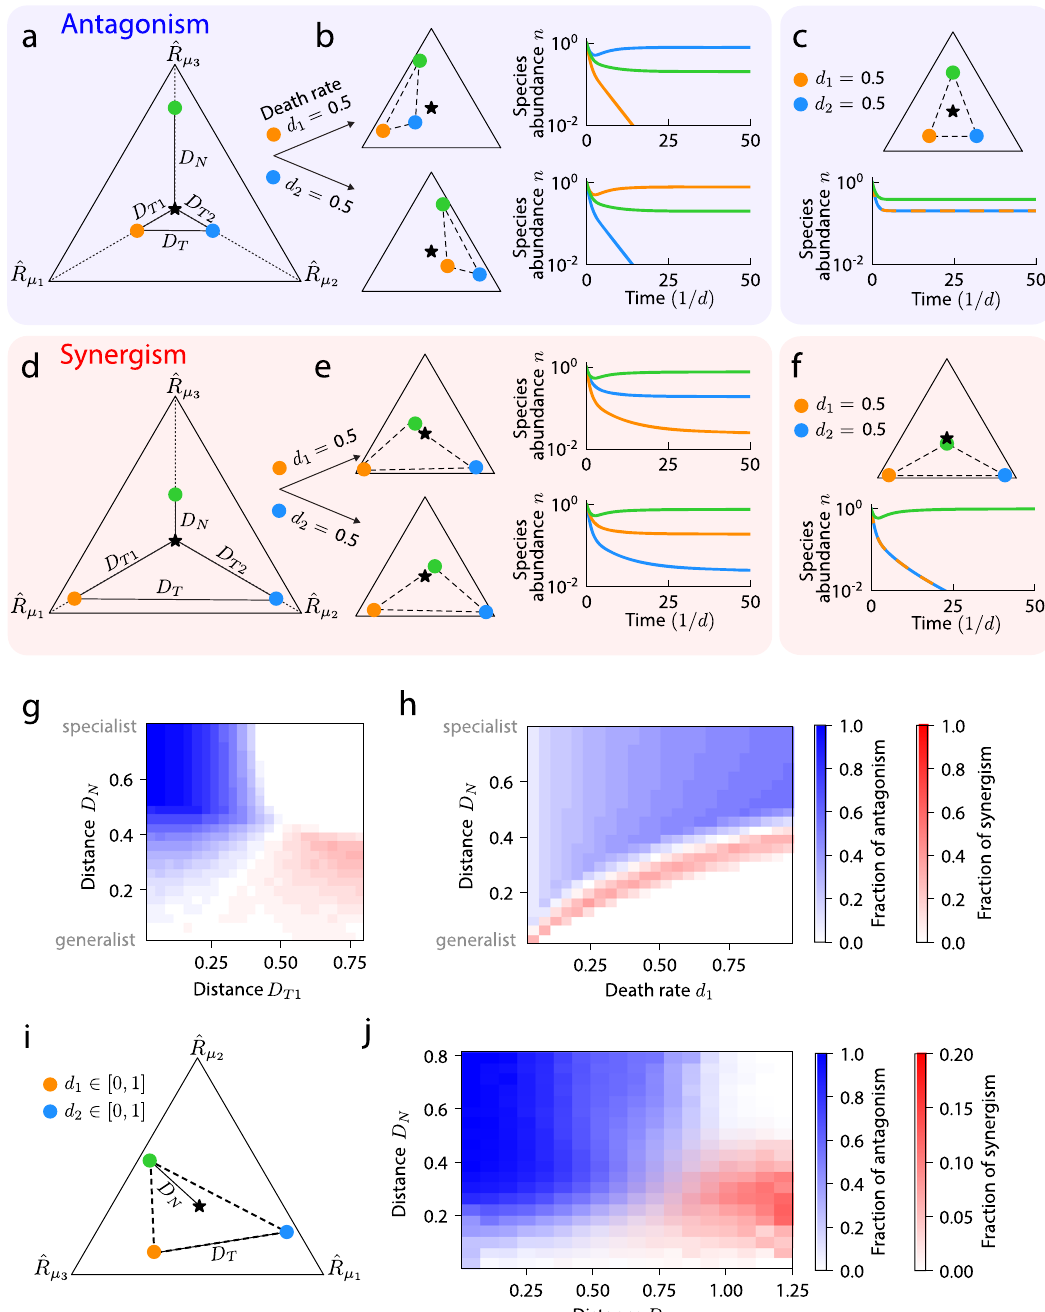
Fig. 5 | Resource competition can lead to non-additive effects during simulta- neous application of two antibiotics, with antagonism more likely than synergism. a A community for which antibiotic targeting leads to antagonism. Beforeantibiotictreatment,allthreespeciescoexisted,asshownbythesimplexof the resource consumption rates of three species (colored circles) along with the supplyratesofthreeresources(star)withdistances D N , D T 1 , D T 2 asinFig.4a,aswell as the distance between the two targeted species D T . b (Top) When the death rate oftheorangespeciesin( a )wasincreased,remappingoftheconvexhullresultedin extinction ofthe orange species. (Bottom)Whenthe death rate ofthe blue species was increased, the blue species similarly went extinct. c When both species in ( a ) were targeted simultaneously, competition between the targeted species was relieved. (Top)Remapping due to both antibiotics led to only small changes in the consumption rate vectors compared with each antibiotic alone, as compared to unperturbed community in ( a ). (Bottom) Coexistence of all three species was